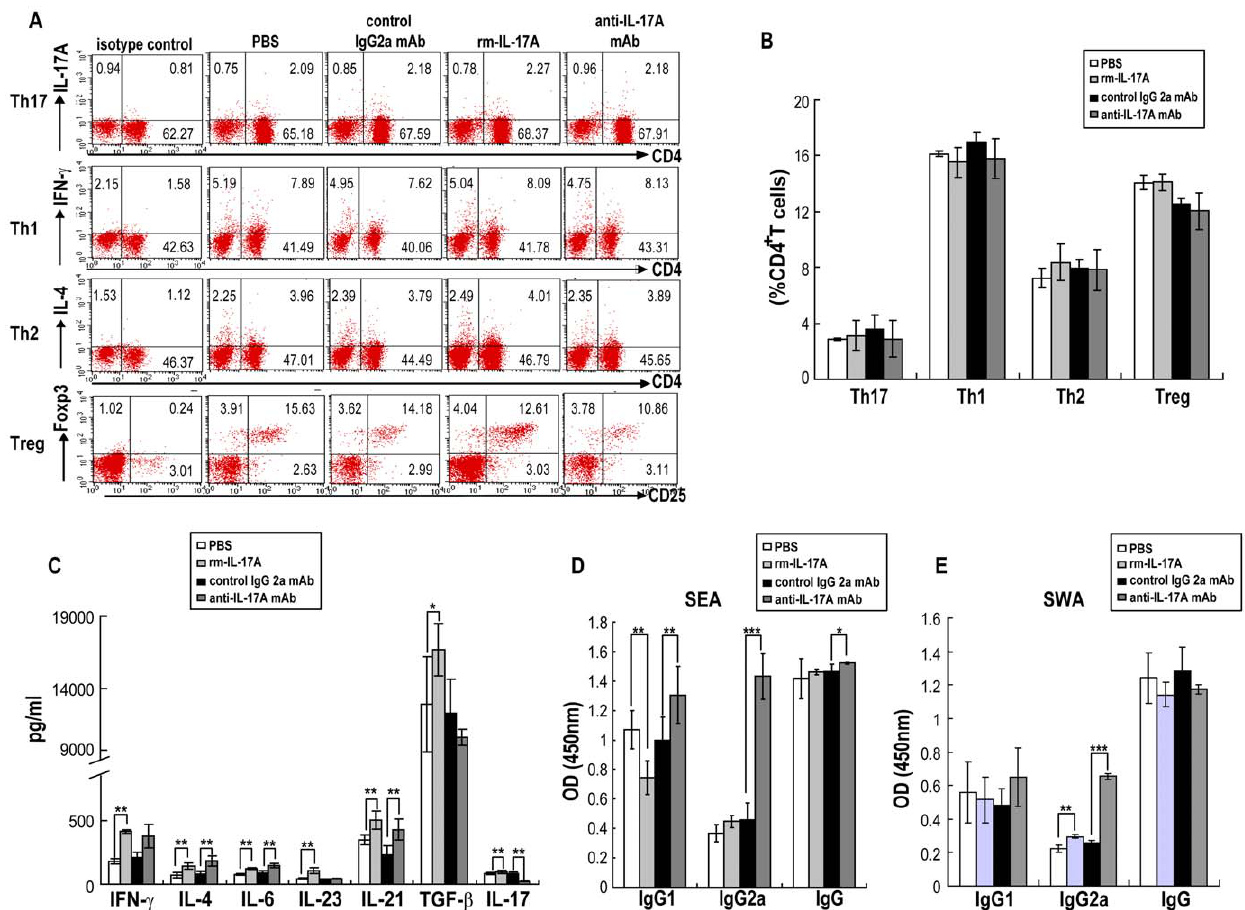
Figure 7. Immune responses in S.japonicum infected mice after administration of rmIL-17A or anti-IL-17A neutralizing mAb. rmIL- 17A, anti-mouse IL-17A mAb or controls were administered to mice, followed by challenge with 40 S. japonicum per mouse. Six weeks after the challenge, the mice were sacrificed, and the splenocytes were prepared. A. Flow cytometric analysis of Th17, Th1, Th2 and Treg cells from one representative experiment. Single cell suspensions of splenocytes were stimulated with PMA/ionomycin in the presence of Golgistop for 6 h, followed by surface staining with anti-CD3-APC and anti-CD4-FITC and intracellularly staining with PE-conjugated antibodies against IL-17A, IFN- c , IL- 4 or isotype IgG2a control antibody for FACS analysis of Th17, Th1 or Th2 cells. Splenocytes were also stained with the Mouse Regulatory T Cell Staining Kit for detection of Treg cells. Cells were gated on the CD3 + population for analysis of Th17, Th1, Th2 cells analysis, or gated on the CD3 + CD4 + population for analysis of Treg cells. B. The proportions of Th17, Th1, Th2 and Treg cells in CD4 + T cells. Results are expressed as mean 6 SD of eight mice from two independent experiments. * P , 0.05; ** P , 0.01; *** P , 0.001, compared to control mice injected with PBS or isotype antibody. C. ELISA detection of cytokines in the supernatant produced by splenocytes from S. japonicum infected mice after administration of rmIL- 17A or anti-IL-17A neutralizing mAb. Splenocytes (2 6 10 5 /well in 200 m l of complete media) were cultured in 96 well plates with PMA/ionomycin. Culture supernatants were collected after 72 h, and cytokines were detected by ELISA. Results are expressed as mean 6 SD of eight mice from two independent experiments. * P , 0.05; ** P , 0.01; *** P , 0.001, compared to control mice injected with PBS or isotype antibody. SEA ( D ) and SWA ( E ) specific IgG, IgG1 and IgG2a antibodies in serum from S. japonicum infected mice after administration of rmIL-17A or anti-IL-17A neutralizing mAb were detected by ELISA. Results are expressed as mean 6 SD of eight mice from two independent experiments. * P , 0.05; ** P , 0.01; *** P , 0.001, compared to control mice injected with PBS or isotype